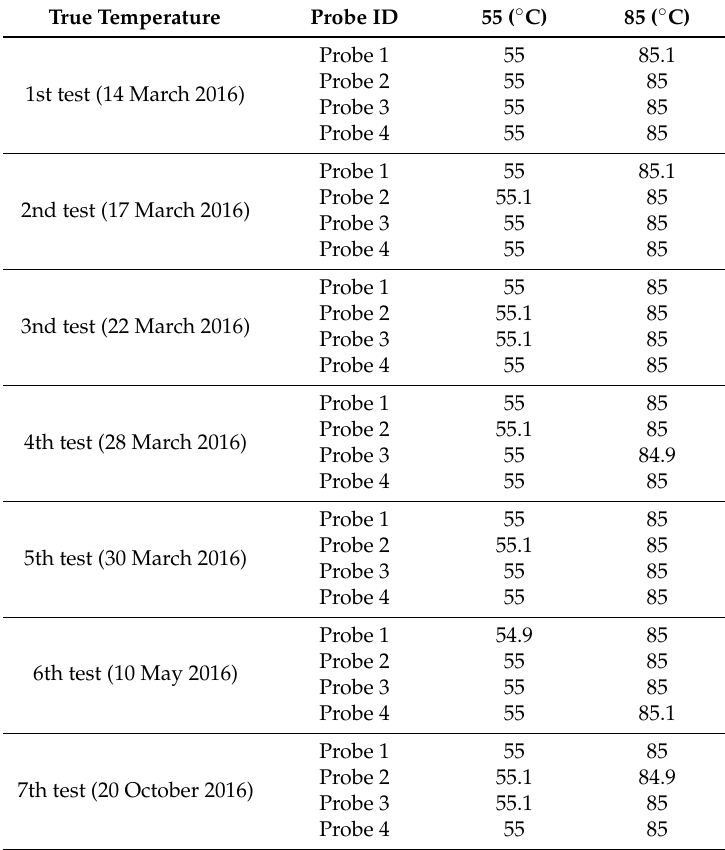
Table 3. Temporal precision